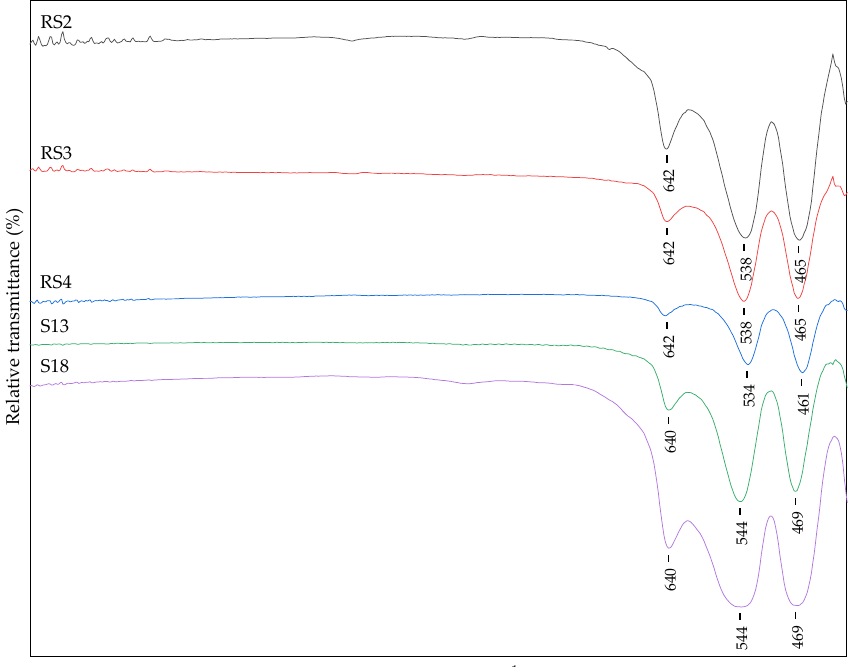
Figure 2. FTIR spectra of the reference samples with varying synthesis times and samples with 1% addition of surfactant PEG and lavender essential oil prepared at 260 °C.